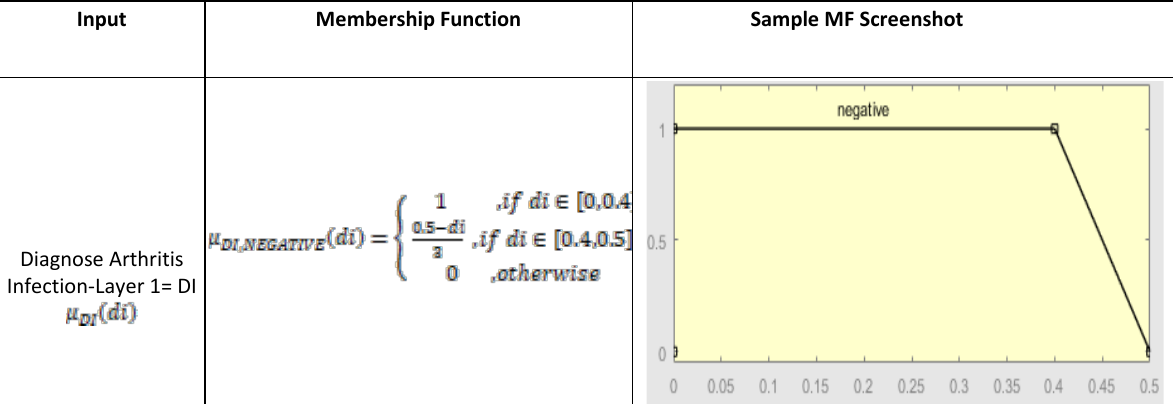
Table 5. Mathematical & Graphical MF of Layer-2 Mamdani Fuzzy Inference System Input